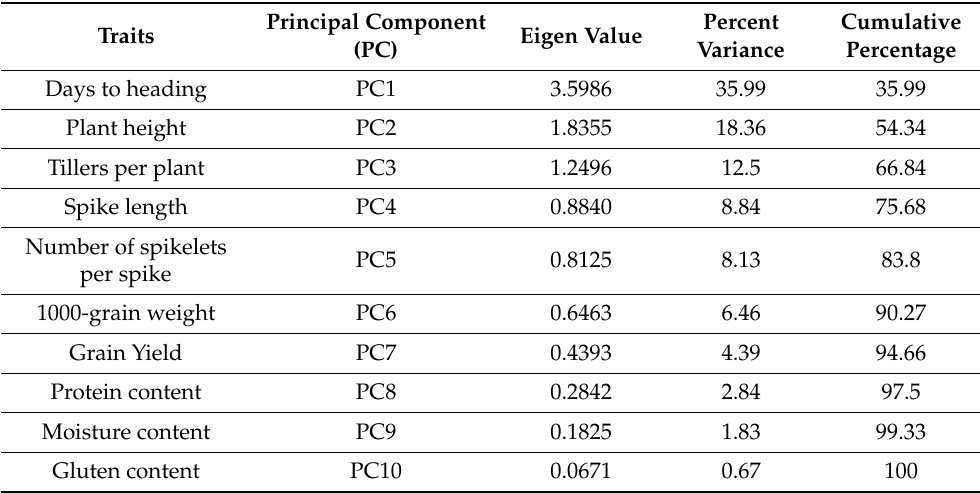
Table 6. Principal component analysis showing Eigen values, percentages of variance, and cumulative percentages for all traits.